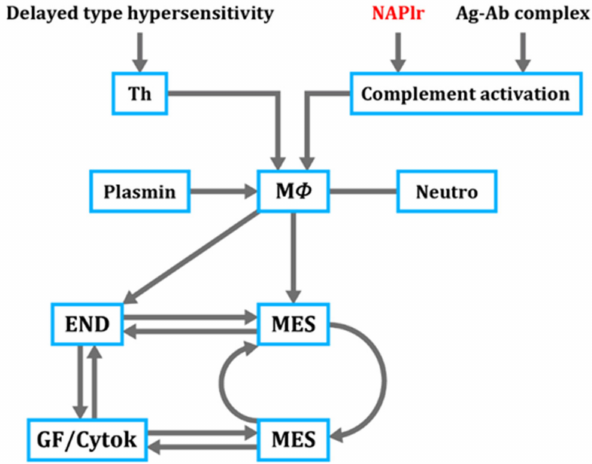
Figure 11. Cell-mediated immune response in PSAGN focused on NAPlr. Th: T helper/inducer cell, Ag-Ab complex: antigen-antibody complex, M Φ : macrophage, Neutro: neutrophil, END: endothelial cell. MES: mesangial cell, END: endothelial cell, GF/Cytok: growth factor/cytokines, NAPlr: nephritis-associated plasmin receptor, PSAGN: post-streptococcal acute glomerulonephritis. Step 5A: IC-Dominant Glomerular Injury